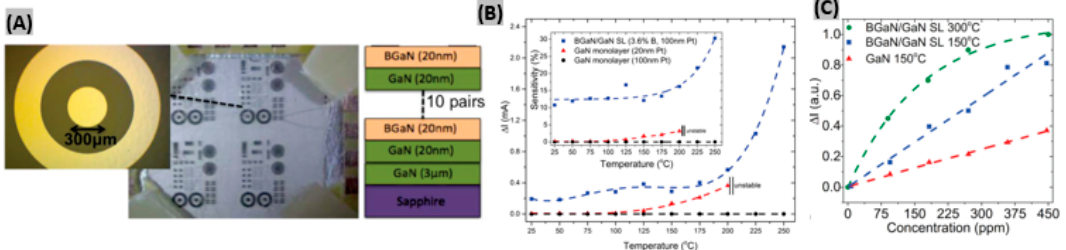
Figure 4. ( A ) Fabricated BGaN/GaN SL and GaN devices. ( B ) Current change and Sensitivity (Inset) of BGaN/GaN SL and GaN sensors to 450 ppm NO 2 at 5 V bias at different temperatures. ( C ) Sensor current changes vs NO 2 concentrations for various temperatures. Figures adapted with permission